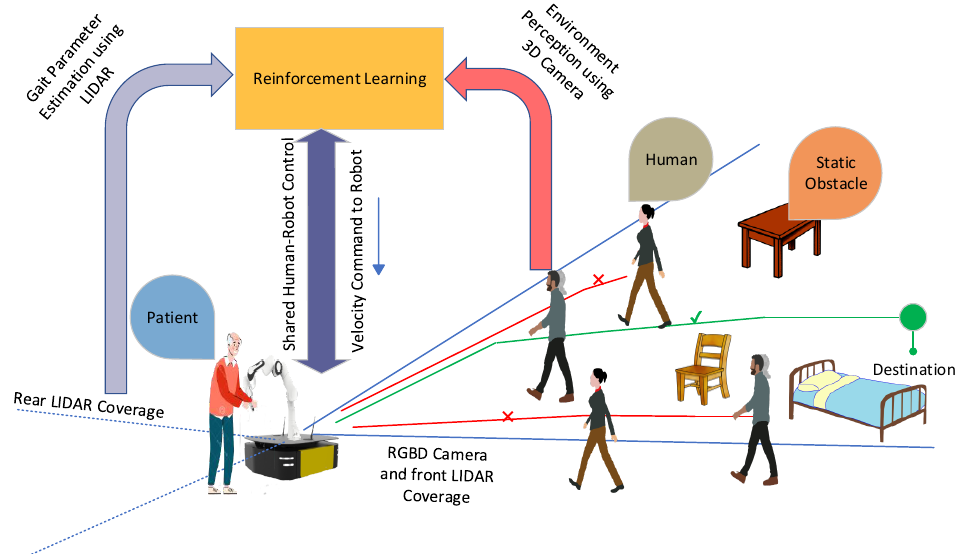
Figure 2. Overview of the patient–robot co-navigation